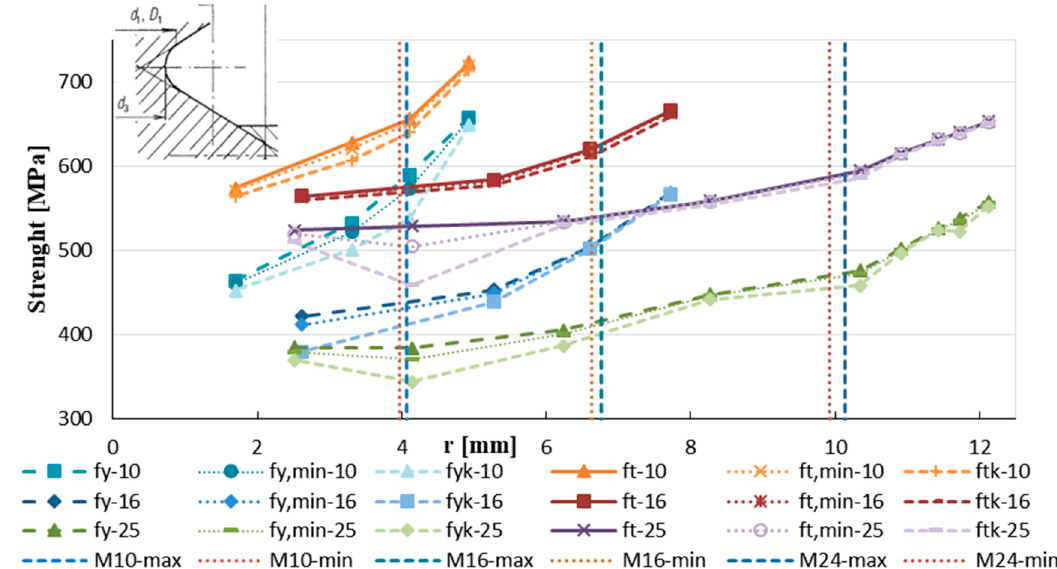
Figure 6. The measured yield and tensile strength of the rebars φ 25A.